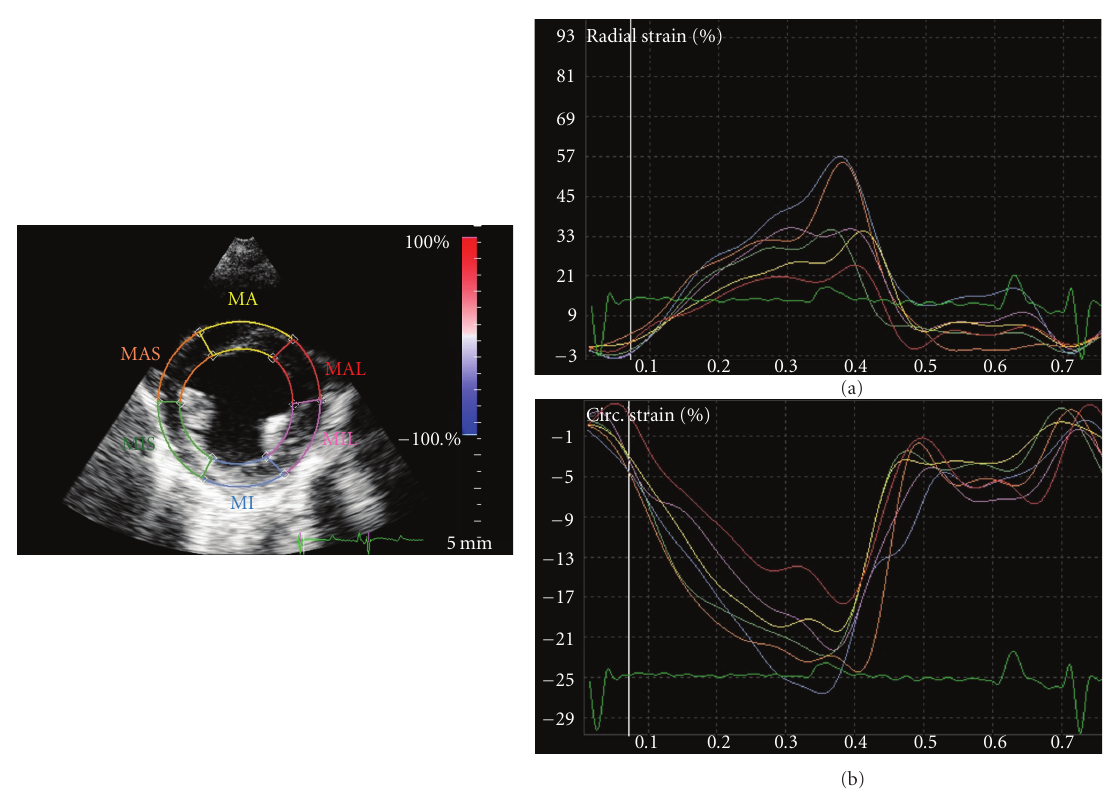
Figure 2: Strain analysis of equally divided six parts at the level of papillary muscles. Yellow and red lines are defined as anterior wall. Both radial strain (a) and circumferential strain (b) showed relatively decreased, yet preserved, strain rate compared with other regions.